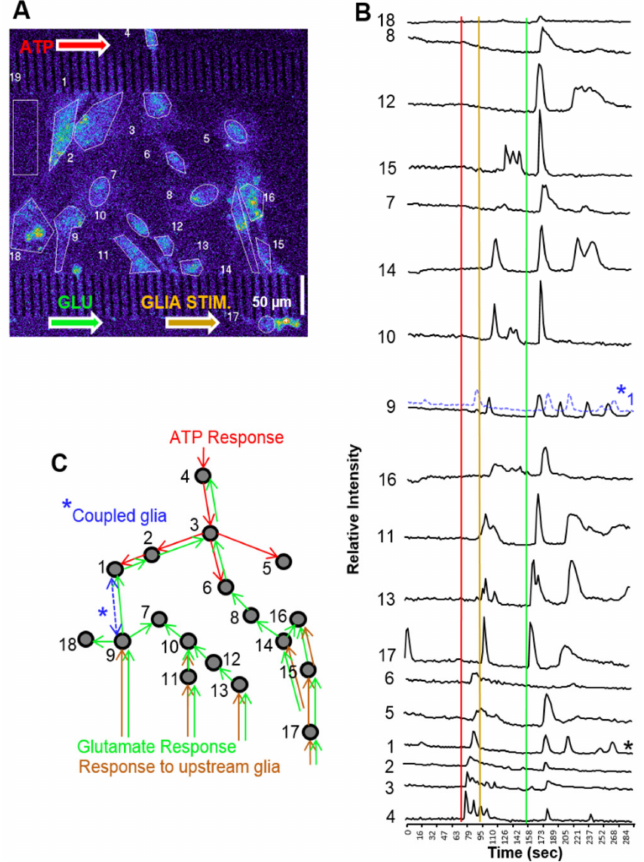
Figure 9. Glial network activation through multipoint stimulation. ( A ) Glial cells were cultured in the central channel of a microfluidic platform for stimulation at opposite sides of the culture for observing network activity. First, 20 µ M ATP was introduced, then 50 µ M glutamate was inserted into the bottom channel. From two chemical stimulations, three network activations occur. ( B ) Background (ROI#19)-subtracted fluorescence intensity profiles of each defined RIO ordered in chronological activation. Temporally coupled glial (*) signals from cellular ROI 1 and 9 suggest the two cells are electrically coupled. Glial cell 1 signal (*1) is superimposed with coupled glia 9 for comparison. ( C ) Schematic summary of Ca 2+ signal propagation through the glial